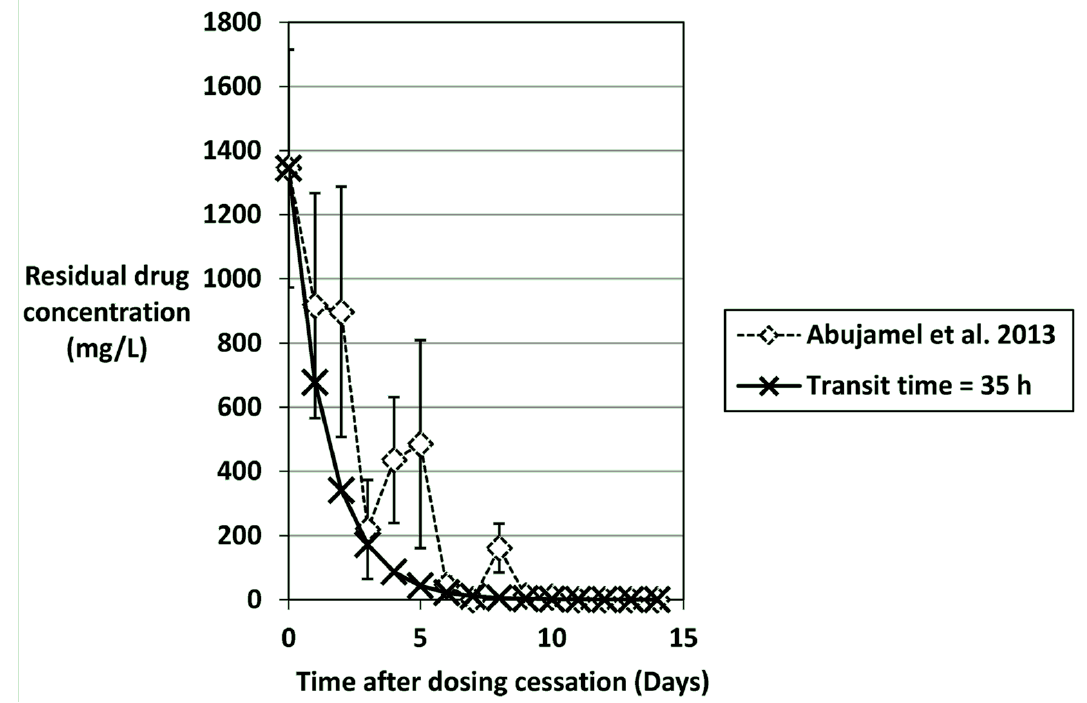
Figure 2. Predicted washout of vancomycin (mg/L) using a mass-balance calculation assuming a gut transit time of 35 hours (dilution rate = 0.029 h −1 ). Vancomycin concentrations (mean ± SE) are from Abujamel et al. [123,161] and mg/kg were assumed to equal